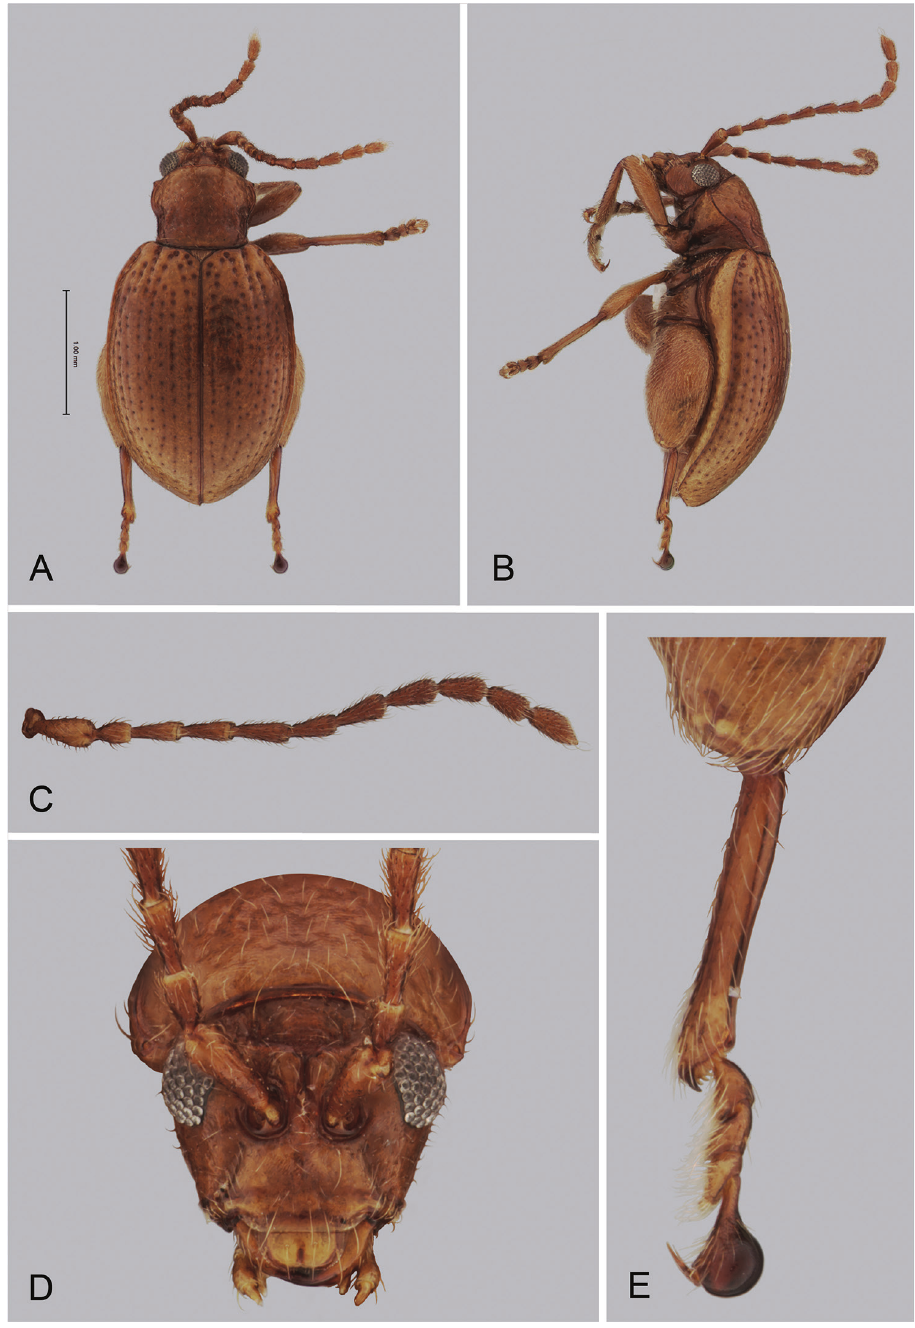
Figure 10. Andersonoplatus flavus . A Habitus dorsal B Habitus lateral C Antenna D Head, frontal view E Hind